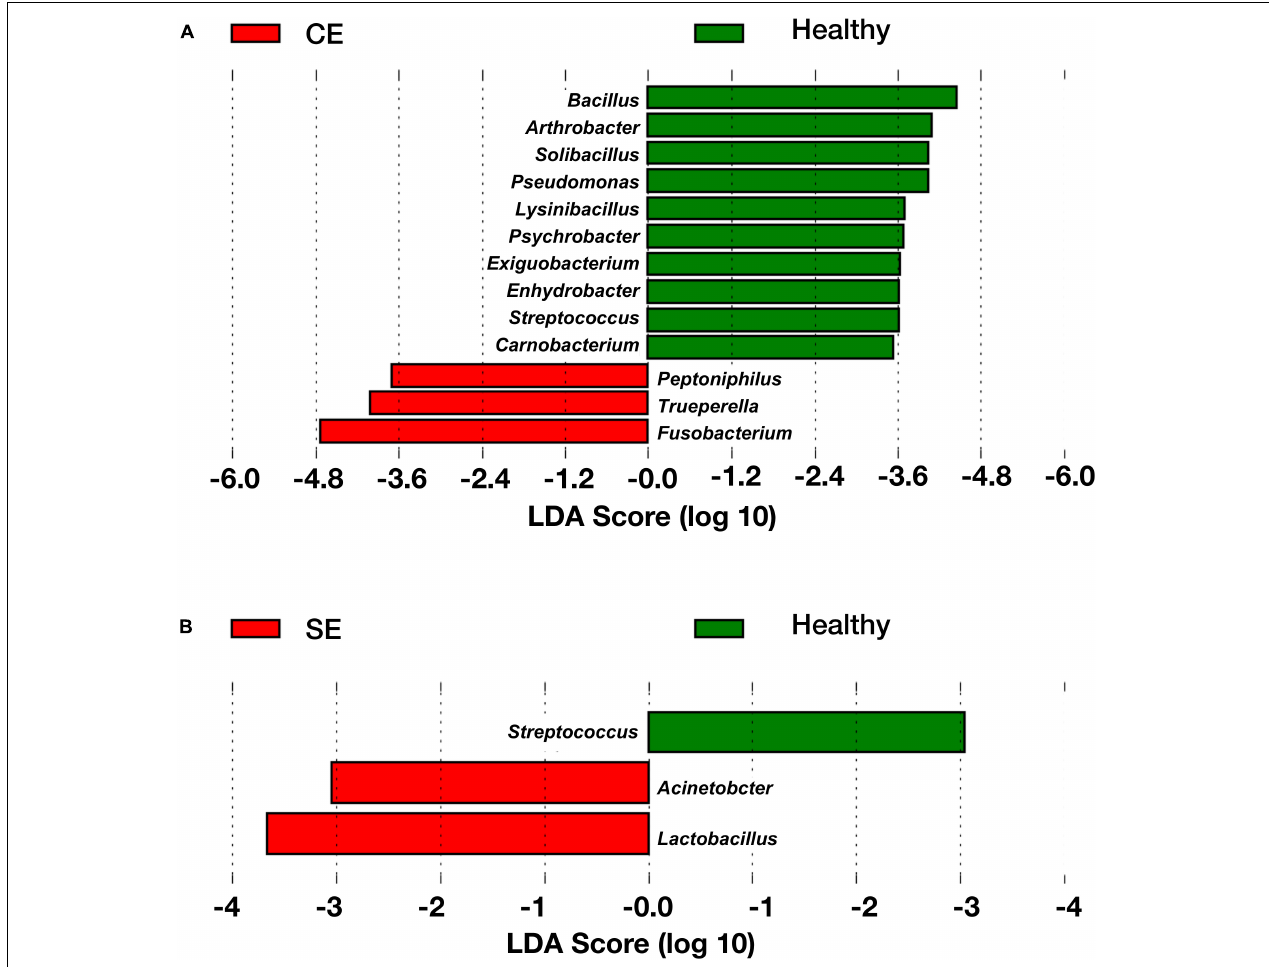
FIGURE 3 | The linear discriminant analysis (LDA) effect size plots showing the differences in the uterine microbiota between healthy cows and CE cows (A) , and between healthy cows and SE cows (B) . The histogram shows the LDA effect size computed for features at genus level. Healthy-enriched genera are indicated with positive LDA scores (green), and genera enriched in CE or SE cows are indicated with negative LDA scores (red). Only genera meeting a significant level of 0.05 and an effect size threshold of 3 are plotted. Healthy, healthy cows, n = 13; SE, subclinical endometritic cows, n = 5; CE, clinical endometritic cows, n =